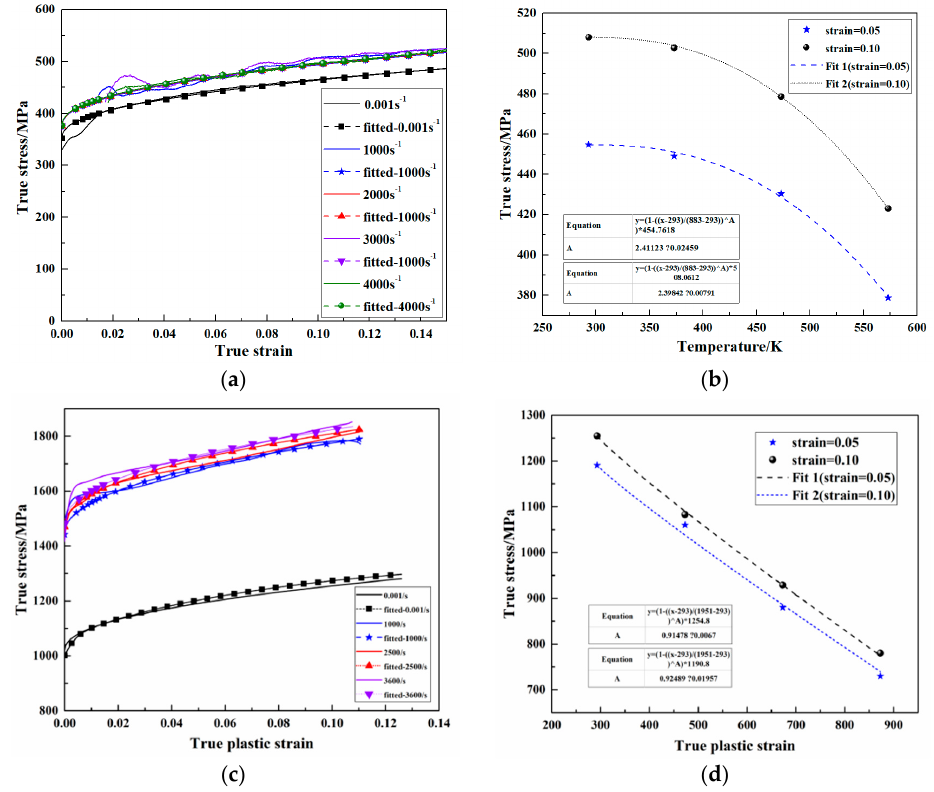
Figure 5. ( a ) True stress versus true strain curves of the 2618 aluminum alloy; ( b ) fitting of temperature sensitivity for the 2618 aluminum alloy; ( c ) true stress versus true strain curves of the Ti-6Al-4V titanium alloy; and ( d ) fitting of temperature sensitivity for the Ti-6Al-4V titanium alloy. Table 1. JC constitutive parameters of the 2618 aluminum alloy and the Ti-6Al-4V titanium alloy. Parameters A (MPa)